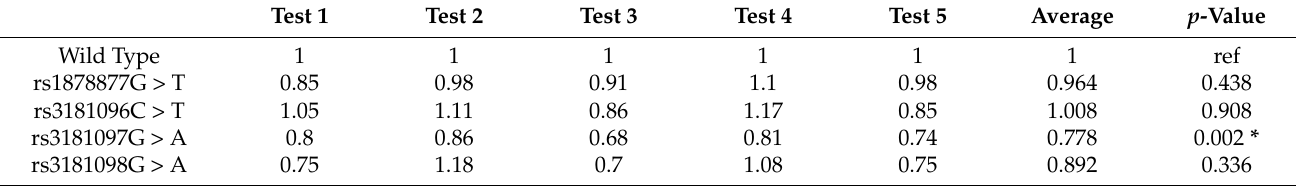
Table 5. The relative light units of the four promoter reporters in each of the 5 tests. Test 1 Test 2 Test 3 Test